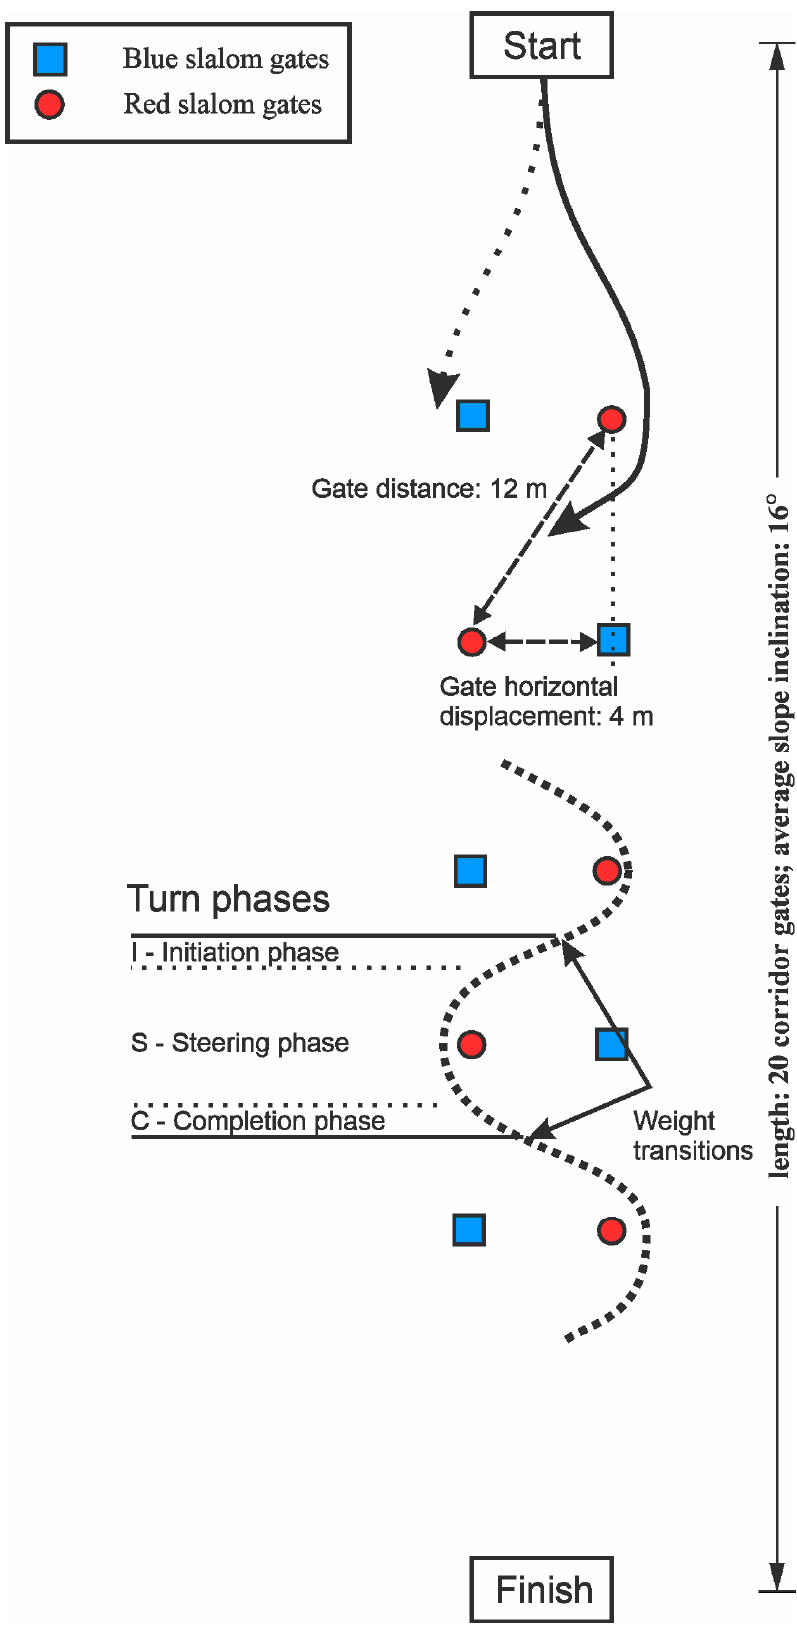
Figure 1. Schematic illustration of the corridor-shaped slalom course.